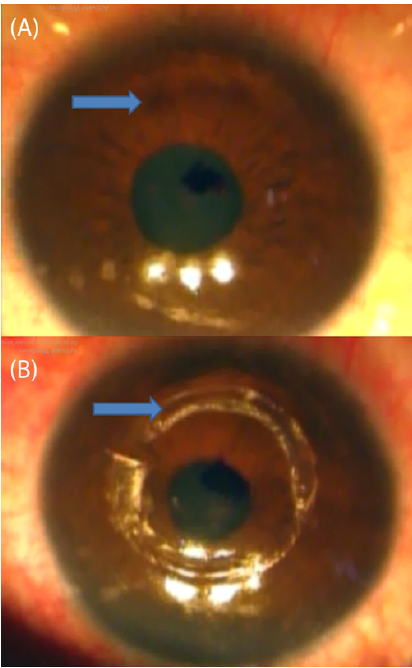
Figure 1: (A) Superior corneal protrusion without associated scarring or vascularization; (B) Two implanted Kerarings Specular examination (Topcon SP-2000P, Topcon, Tokyo, Japan) of the left eye revealed normal corneal endotheli-